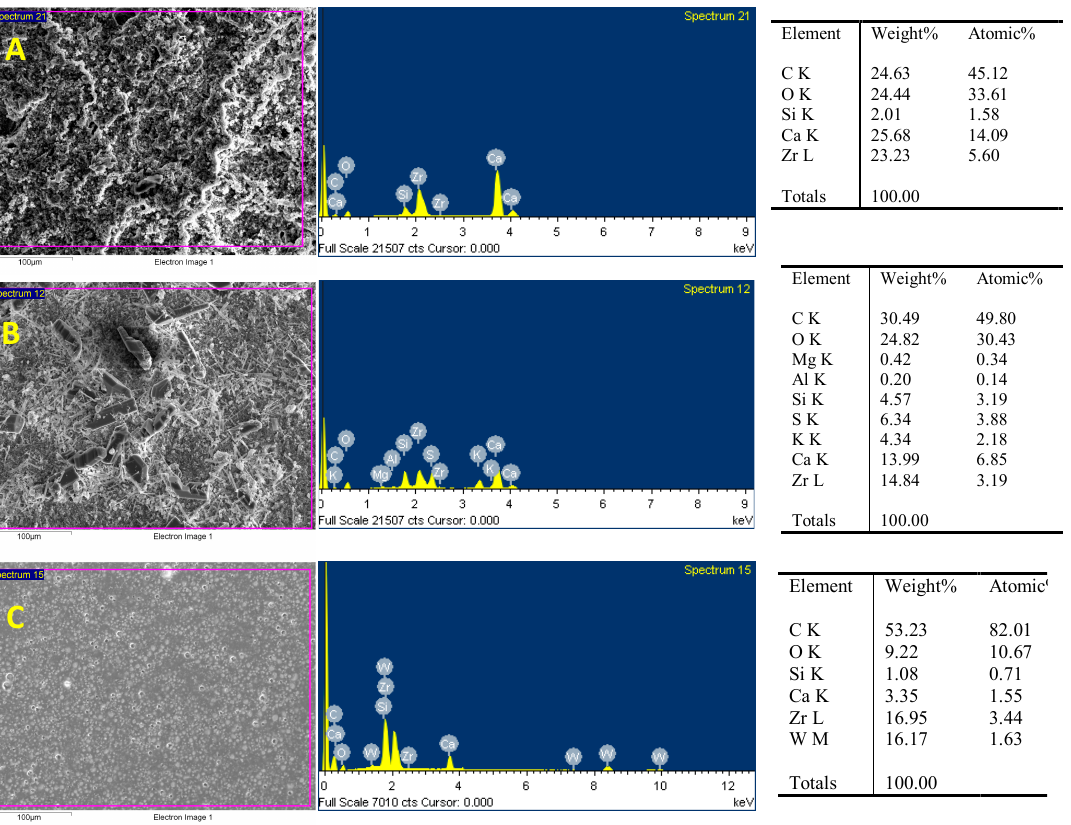
Figure 5. Surface properties and composition of Bio-C Sealer ( A ) and TotalFill BC Sealer ( B ) and AH Plus ( C ) under a scanning electron microscope with energy-dispersive X-ray analysis